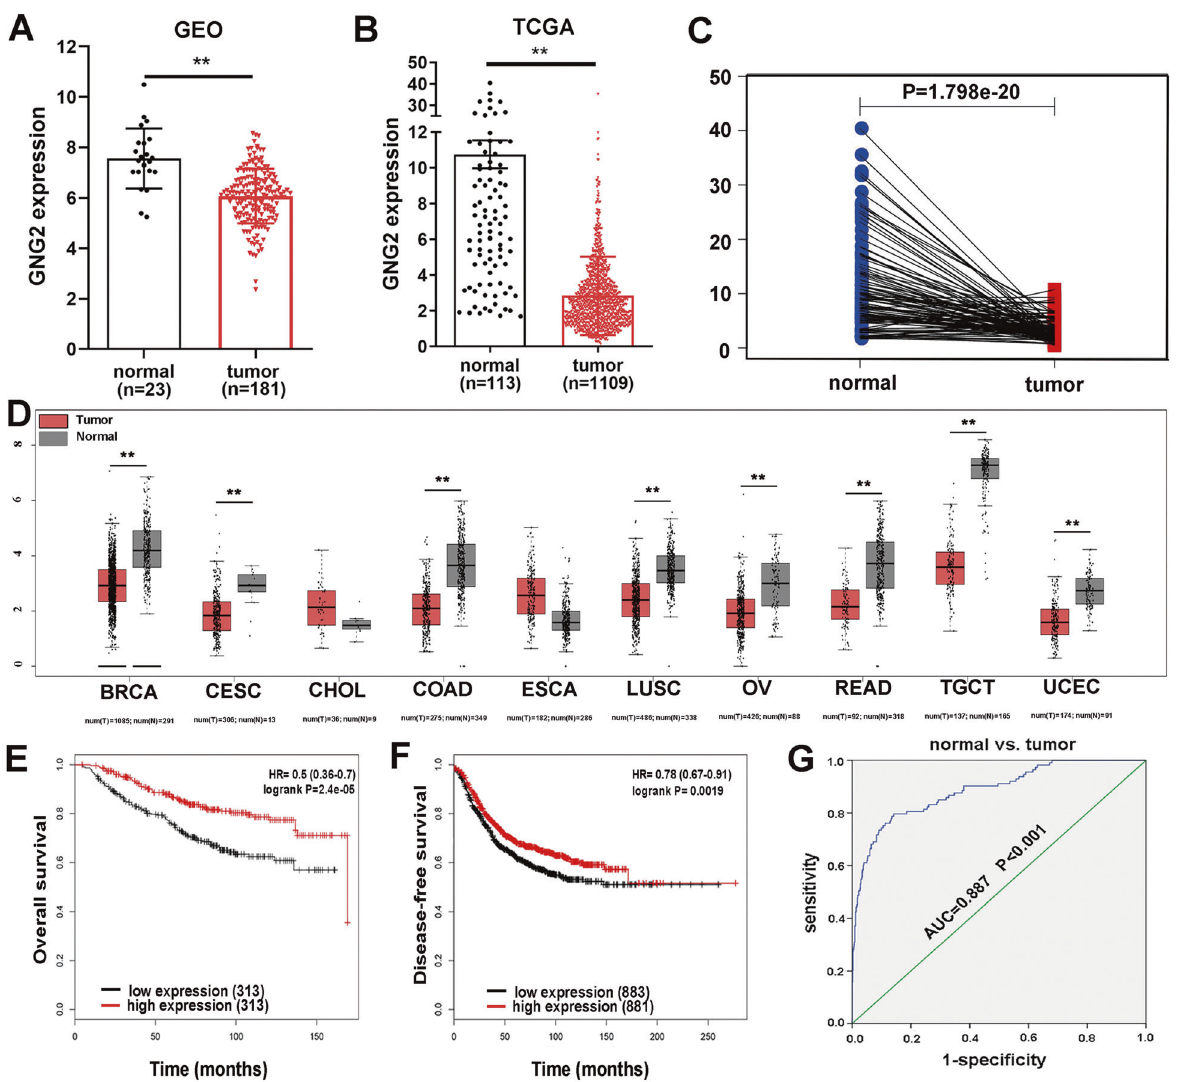
Fig. 2 Identi fi cation of GNG2 in breast cancer (BC). A and B GNG2 expression levels were obtained from the GEO database ( A ) and TCGA database ( B ) in normal and BC tissues. C The pairing difference analysis of GNG2 expression between tumor and normal tissues. D GNG2 expression obtained from GEPIA analysis in multiple cancers including BC, and cervical squamous cell carcinoma (CESC), etc. E Kaplan-Meier survival curves for overall survival (OS) according to GNG2 expression levels in BC subjects. F Disease-free survival (DFS) curve based on GNG2 expression levels in BC subjects. G ROC curve for GNG2 expression in normal and BC tissues. Error bars indicate SEM. ** p <